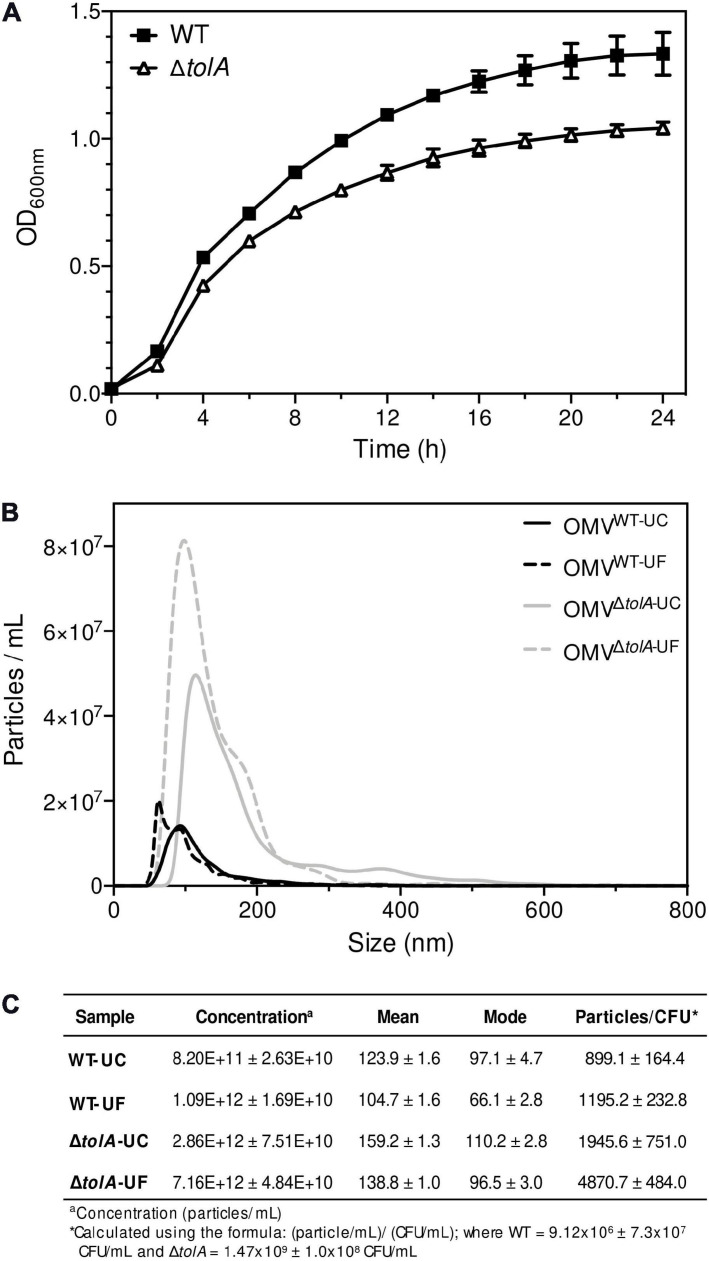
Growth curve analysis of Escherichia coli wild-type and ΔtolA and NTA measurements of their isolated OMVs. (A) Growth curves of BW25113 (WT) and JW0729 (ΔtolA) E. coli strains. OD600 nm measurements (y-axis) are shown over time (h; x-axis) for WT (squares) and ΔtolA (triangles) strains grown in LB broth at 37°C plates every 2 h for 24 h at 37°C. Growth curves represent the mean of two biological samples measured in triplicate (n = 6), where error bars represent the standard deviation of mean value. WT and ΔtolA growth were significantly different for each time point except 0 h according to a Mann–Whitney U test (p < 0.05). (B) OMVs isolated from WT and ΔtolA strains using either UC or UF methods (refer to panel legend) were diluted 1,000-fold and measured using a Nanosight NS500. All data represent the mean of triplicate experiments ± standard error. (C) A summary of NTA data collected, listing WT and ΔtolA mean vesicle size (nm), mode size (nm), concentration (particles/mL), and particles/CFU for each isolation method.